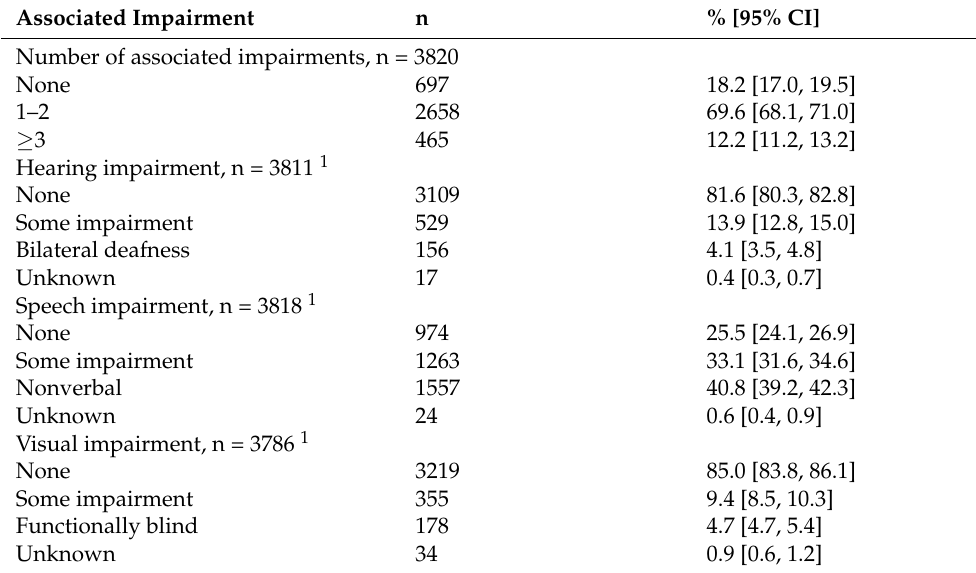
Table 2. Presence of associated impairments among children with CP in